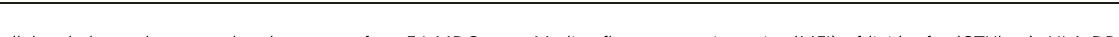
Fig. 7 Lowering cellular cholesterol rescues the phenotype of apoE4 MDCs. a – c Median fl uorescence intensity (MFI) of lipid rafts (CTXb, a ), HLA-DR ( b ), CD80 ( c ) in immature (LPS − ) and mature (LPS + ) MDCs. d and e Relative quanti fi cation of lipid rafts (CTXb, d ) and free cholesterol ( fi lipin, e ) in immature (LPS − ) or mature (LPS + ) apoE4 MDCs cultured with serum derived from an allogenic apoE4 donor as compared to an apoE3 donor. Data are presented as relative expression compared to immature apoE4 MDCs cultured with serum from an allogenic apoE4 donor. f Determination (ng/ µ g) of sterols and oxysterols by gas chromatography-mass spectrometry of mature (LPS + ) apoE4 MDCs cultured with serum from an allogenic apoE4 or apoE3 donor. g Relative expression of HLA-DR in immature (LPS − ) or mature (LPS + ) apoE4 MDCs cultured with serum derived from an apoE4 donor as compared to immature (LPS − ) apoE4 MDCs cultured with serum from an apoE4 donor; data are presented as relative expression (calculated from HLA- DR + cells) compared to immature apoE4 MDCs cultured with serum from an apoE4 donor. h Differentiation of CD4 + T naive cells from a carrier of apoE3 isoform with allogenic mature (LPS + ) apoE4 MDCs cultured with serum from an apoE4 or apoE3 donor. i Heat-map of lipid-related and in fl ammatory genes in mature (LPS + ) MDCs from apoE4 carriers cultured in the presence of serum from allogenic apoE4 or an apoE3 donor; data are presented as relative to mean expression in apoE3 DCs (log2 scale). N = 4 – 6 per group. Statistical analysis was performed with two-way Anova. Data are reported as mean ± SEM; * p < 0.05, ** p <